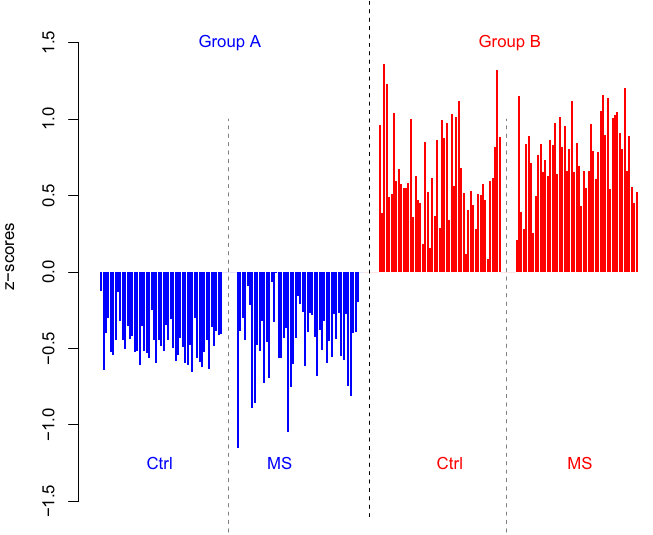
Figure 2. Cohort 1. Bar plots of IgGs significant by confidence intervals (95%) of the proteome for group A versus group B as analysed within MS patients and within controls. Each bar is the mean of one protein for one of the four categories: controls in group A (Group A, Ctrl, blue bars, n = 55), MS patients in group A (Group A, MS, blue bars, n = 7), controls in group B (Group B, Ctrl, red bars, n = 9), and MS patients in group B (Group B, MS red bars, n = 30). The identities of these IgG proteins are given in Supplementary Table S2. The y-axis is the abundance levels expressed as z-scores obtained by subtracting means and dividing by standard